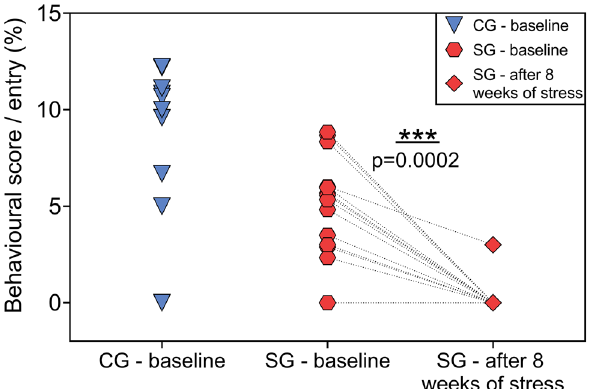
Figure 1. Elevated plus maze (EPM) behavioural test results. First two columns show baseline scores per entry into the open arms of the EPM of each animal from the control (CG) and stressed (SG) group. Results presented in last column are scores gained by animals from stressed group after eight weeks of stress. The dotted lines indicate the change between before and after CUMS protocol for individual animal from SG group. P-value (p = 0.0002) was obtained using a non-parametric Wilcoxon test for paired